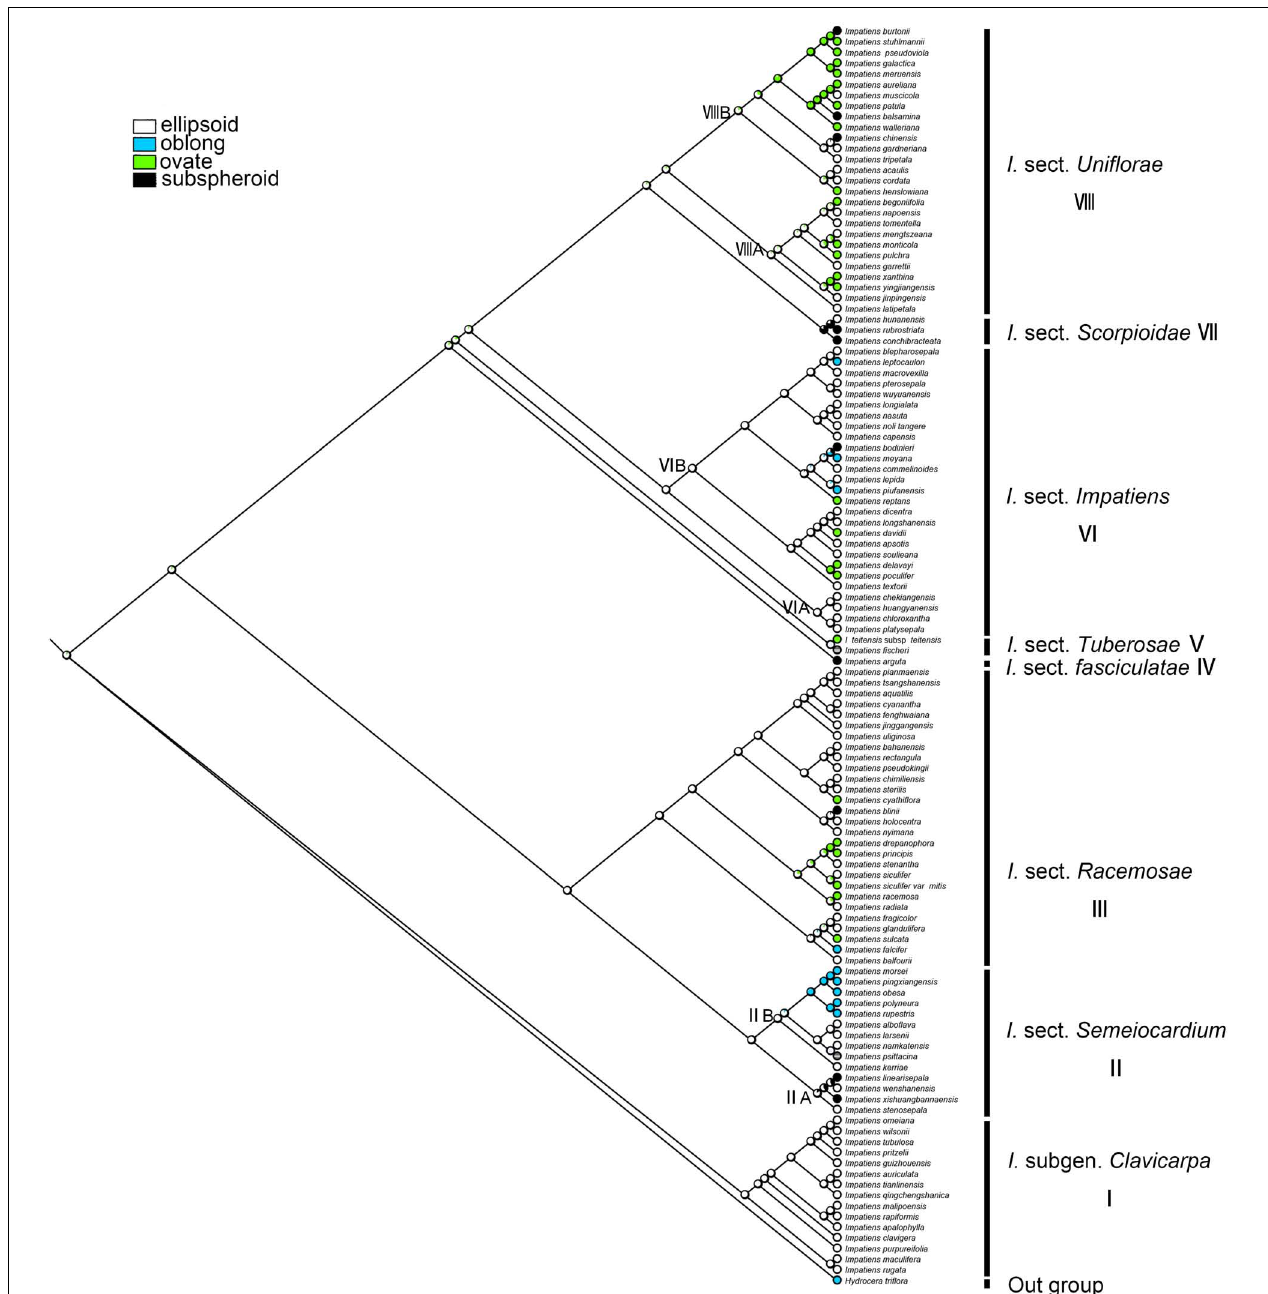
FIGURE 7 | Ancestral reconstruction of the seed shape in Impatiens using ML. Four characteristic states of seed shape of Impatiens optimized on the BI tree by using different colors.